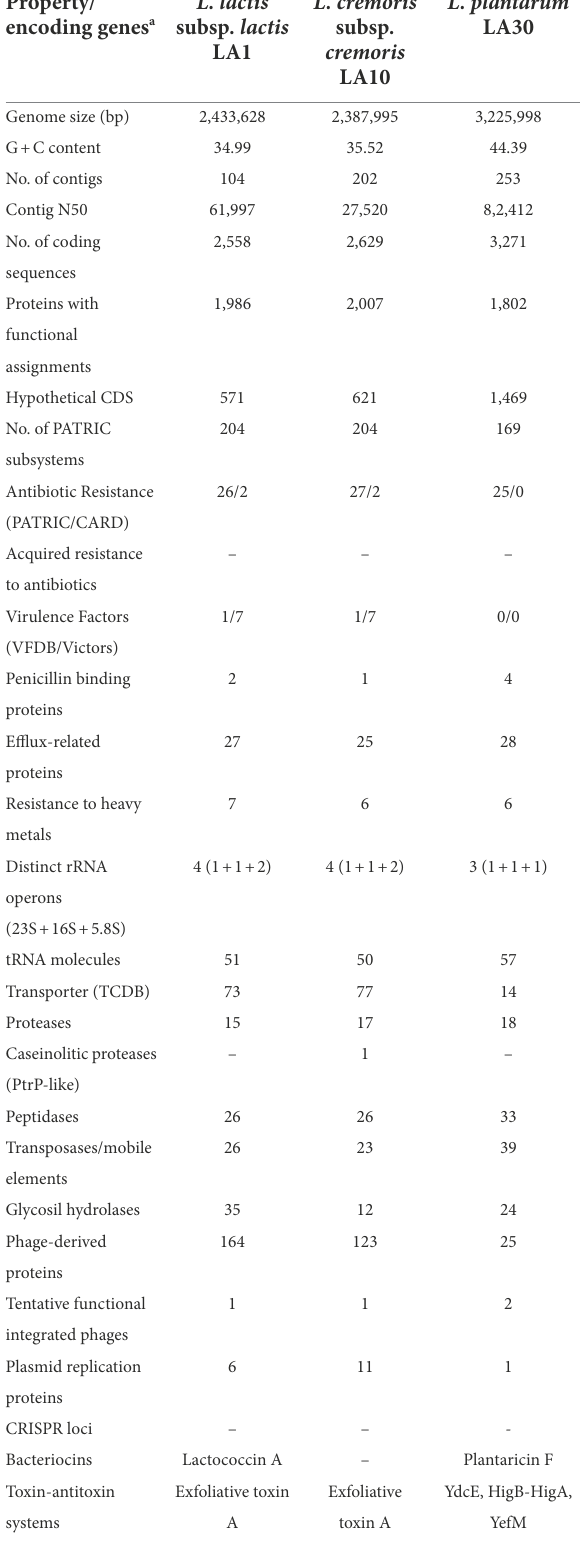
TABLE 6 General features of the genome sequences of L. lactis subsp. lactis LA1, L. cremoris subsp. cremoris LA10, and L. plantarum LA30 strains from the fermented milk